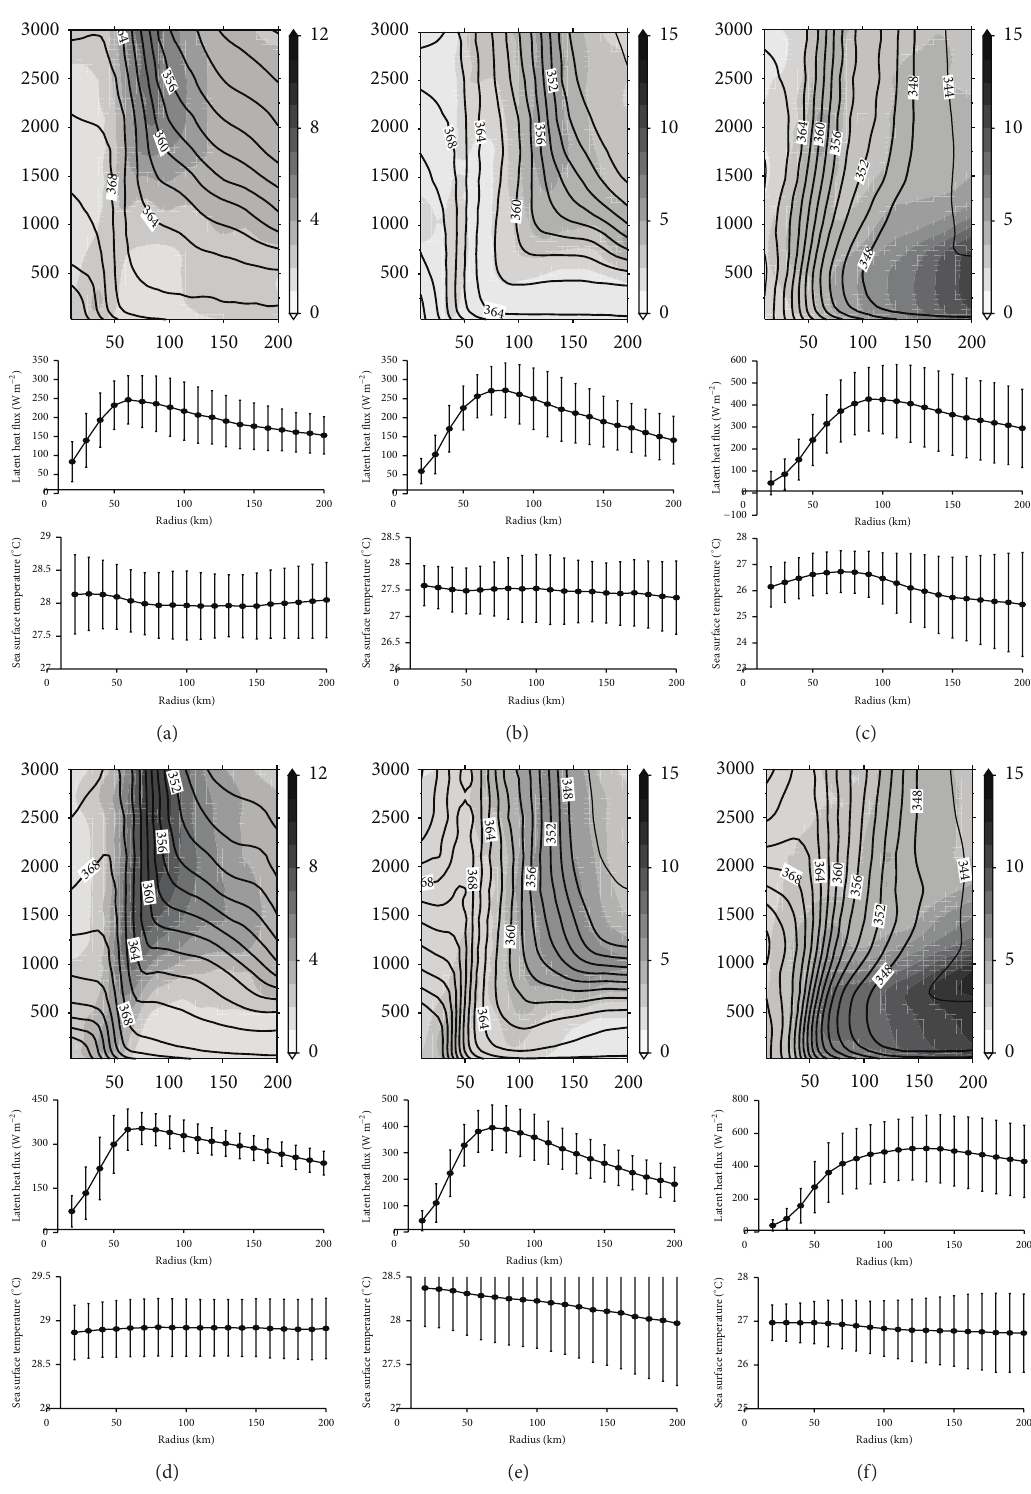
Figure 5: Vertical profiles of the axisymmetric mean equivalent potential temperature (contours; contour interval, 2K) of all experiments and standard deviations (shading) (upper panels), the axisymmetric mean latent heat flux (line) and standard deviations (vertical bars) (middle panels), and the axisymmetric mean sea surface temperature (line) and standard deviations (vertical bars) at (a) 24h, (b) 48h, and (c) 69 h. The distance from the center of the simulated typhoon (i.e., the TC radius) is shown on the horizontal axis. (d)–(f) Same as (a)–(c), but showing the results of simulations with the uncoupled atmosphere model. The unit of the vertical axis is